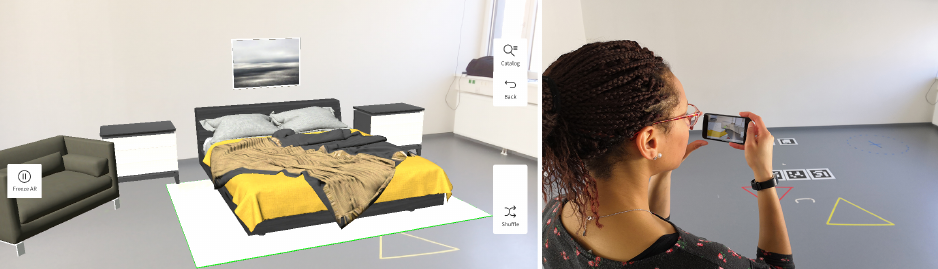
Figure 4. ( Left ) Augmented reality visualization in our system for automated interior design. ( Right ) A user exploring an interior design space on a mobile device using AR. Markers on the floor were used only to provide additional features for ARKit tracking.